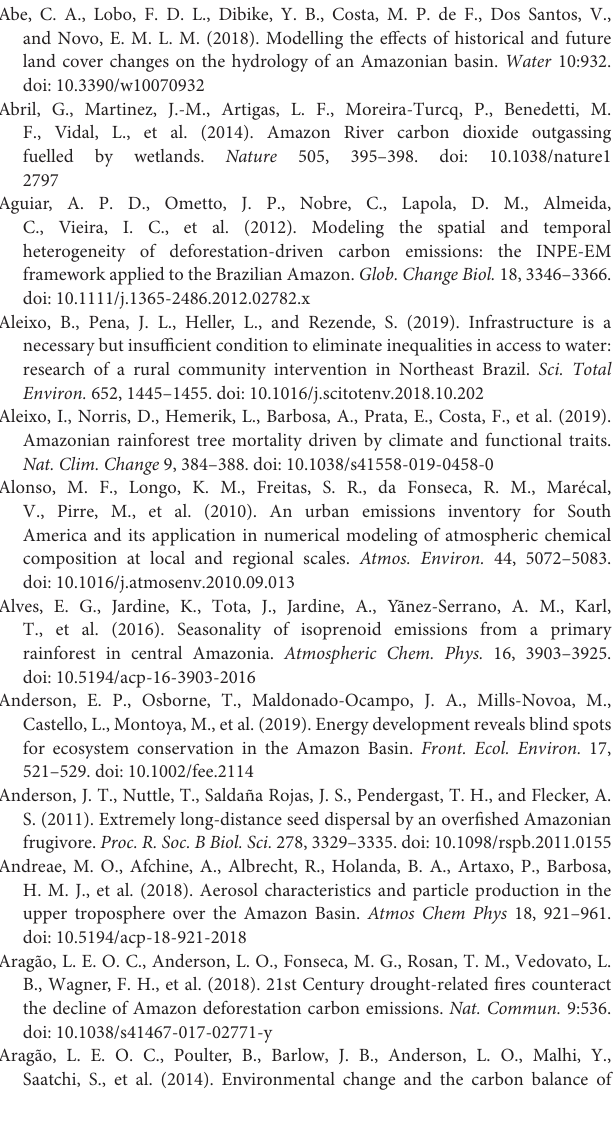
Supplementary Table 2 | List of suggested additional sources concerning conceptual underpinning of biogeochemical cycling and global change in the Amazon Basin.